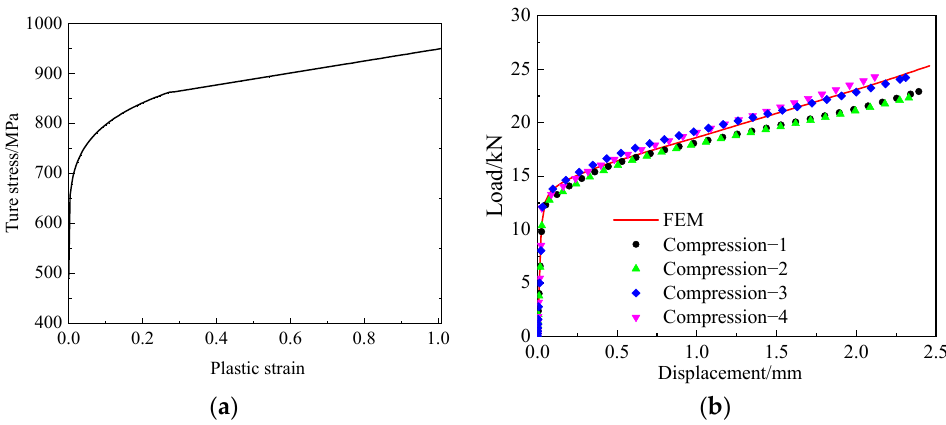
Figure 8. X80 girth weld constitutive model: ( a ) hardening curve; ( b ) comparison of test results with FEM.